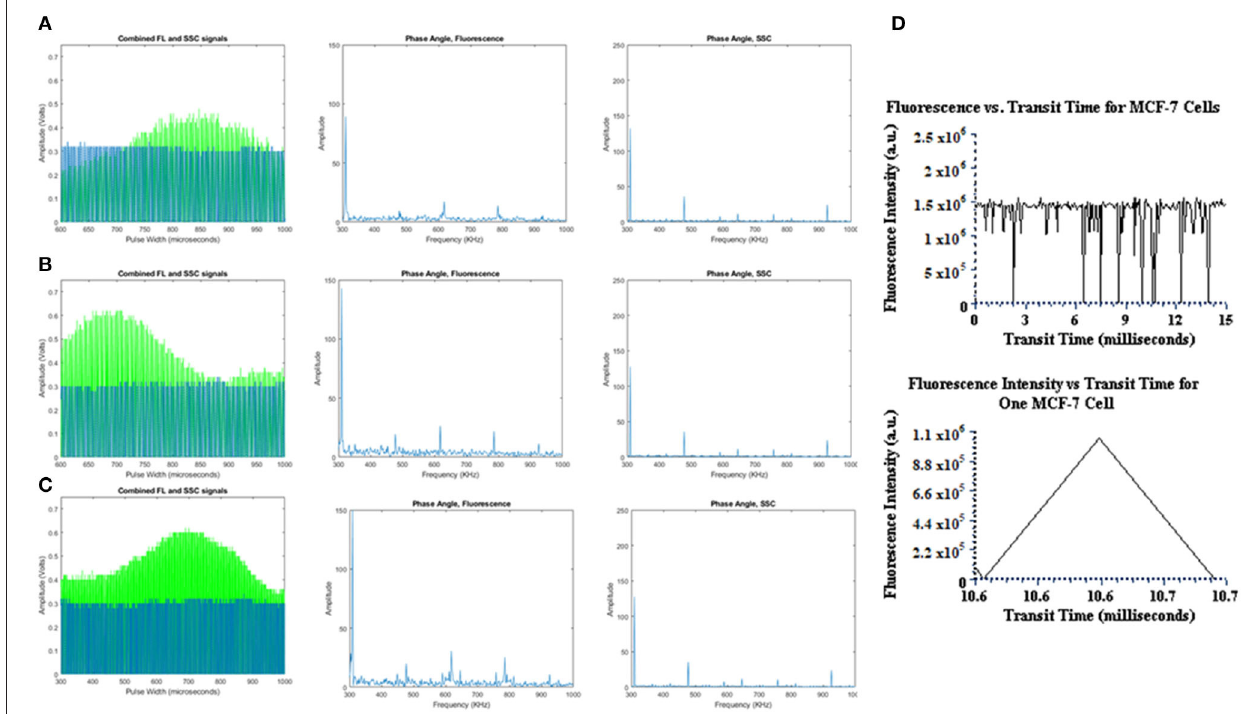
FIGURE 4 | Acoustic focusing performance. (A) Unfocused FlowCheck ® particles passing through the device at 10 µ L/min. White bar equals 100 pixels. (B) Acoustic field activated, and particles align to the pressure node in the center of the device’s channel. (C) Graphical representation of acoustic focusing in-action. As the particles pass through the PZT generated SAW, alignment takes place along central pressure node. (D) Transit time in milliseconds vs. fluorescence intensity plotted for MCF-7 cells (up to 15 milliseconds) and the transit time ( ∼ 200 µ s) for a single MCF-7 cell in milliseconds.